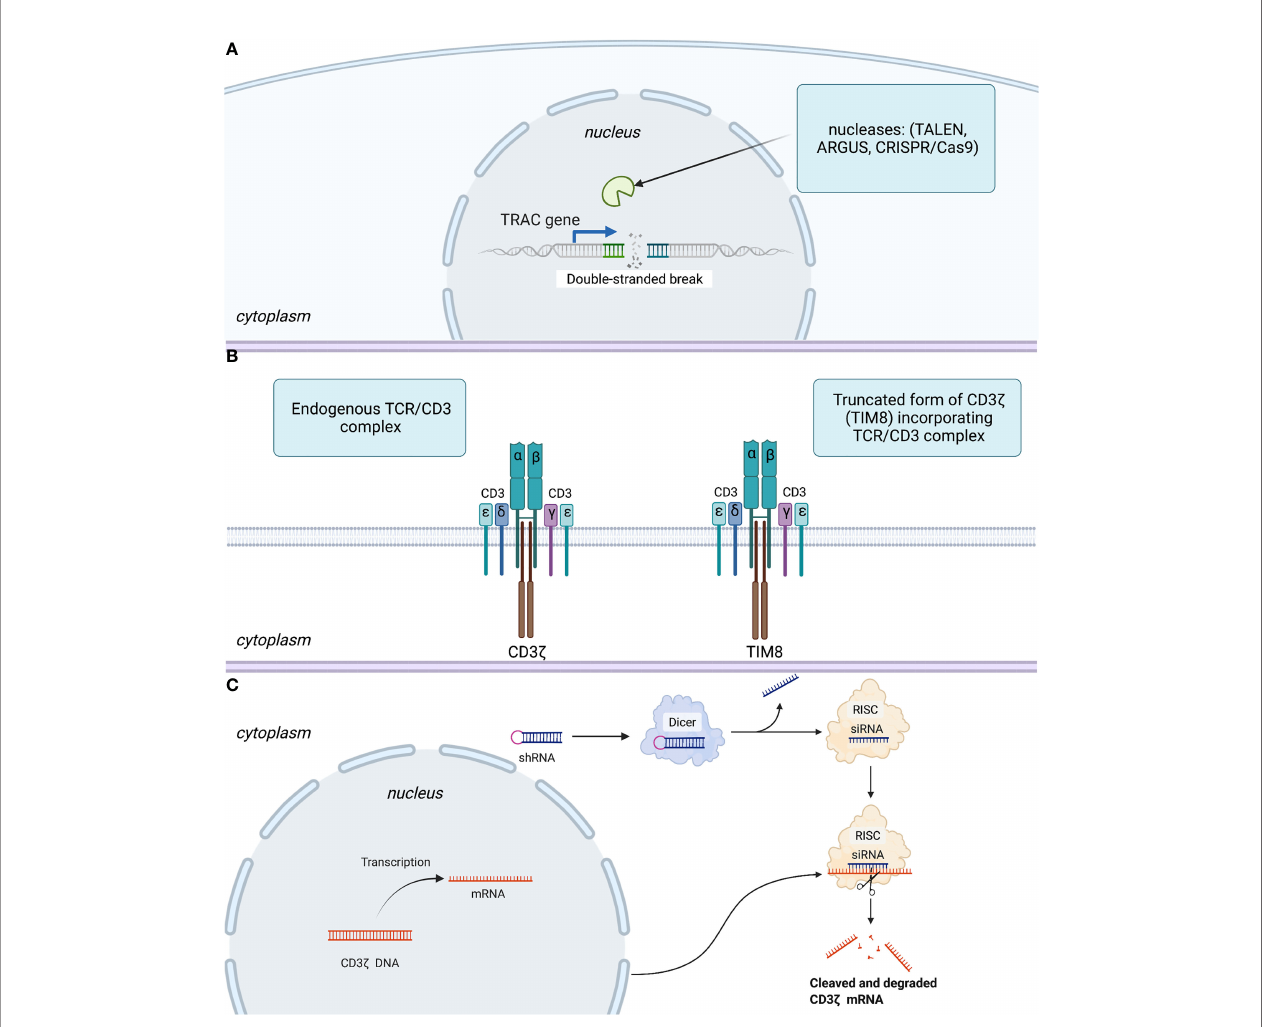
FIGURE 2 | Three basicstrategies to disrupt expression or signaling of TCRs. (A) AbolishingTCR expression by introduction of a double-stranded break in TRAC gene. ( B ) Interferingwith TCR signalingusing a competitive inhibitorofCD3 z -TIM8. (C) Leveraging an RNA interference regulatorymechanism to silence mRNA codingfor the CD3 z component ofthe TCR.More speci fi cally, RNaseIII endonuclease (Dicer) cuts the loopof the introduced shRNA homologous to the target within the CD3 z genome. Furthermore, a guidestrand (siRNA)isincorporatedin the RNA-inducedsilencing complex (RISC), with subsequent transcriptional silencingof the target